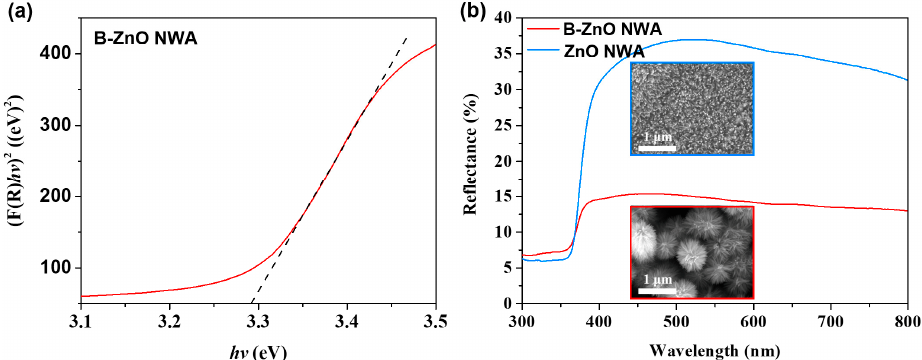
Figure 7. ( a ) Tauc’s plot of B-ZnO NWA. ( b ) UV-vis diffuse reflectance spectra of B-ZnO NWA and ZnO NWA.